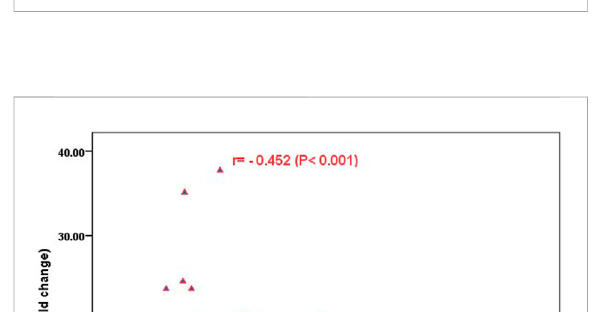
FIGURE 4 Correlation analysis between the expression of GAS5 and platelet count after treatment. There was a negative correlation between GAS5 fold change and platelet count after treatment ( r = -0.438, p < 0.001).